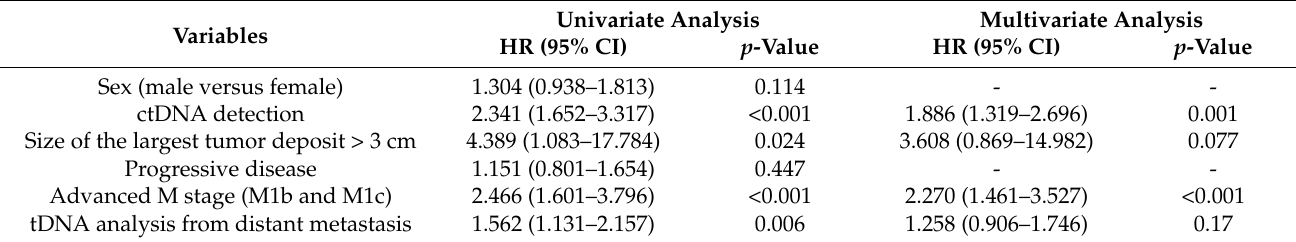
Table 7. Univariate and multivariate analysis of survival analysis and clinicopathological parameters.